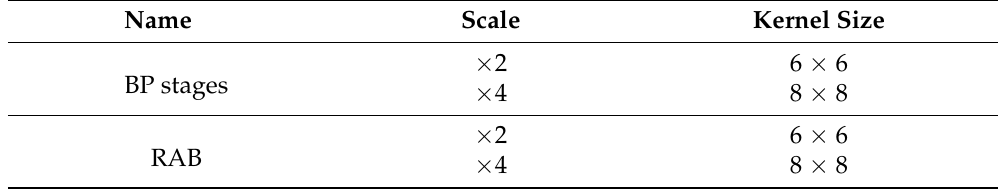
Table A2. The part structure of networks. Note: The use of large-sized filters is avoided because it can slow down the convergence speed and might produce sub-optimal results. However, the iterative up- and down-sampling units enable the mutual relation between LR and HR radar echoes